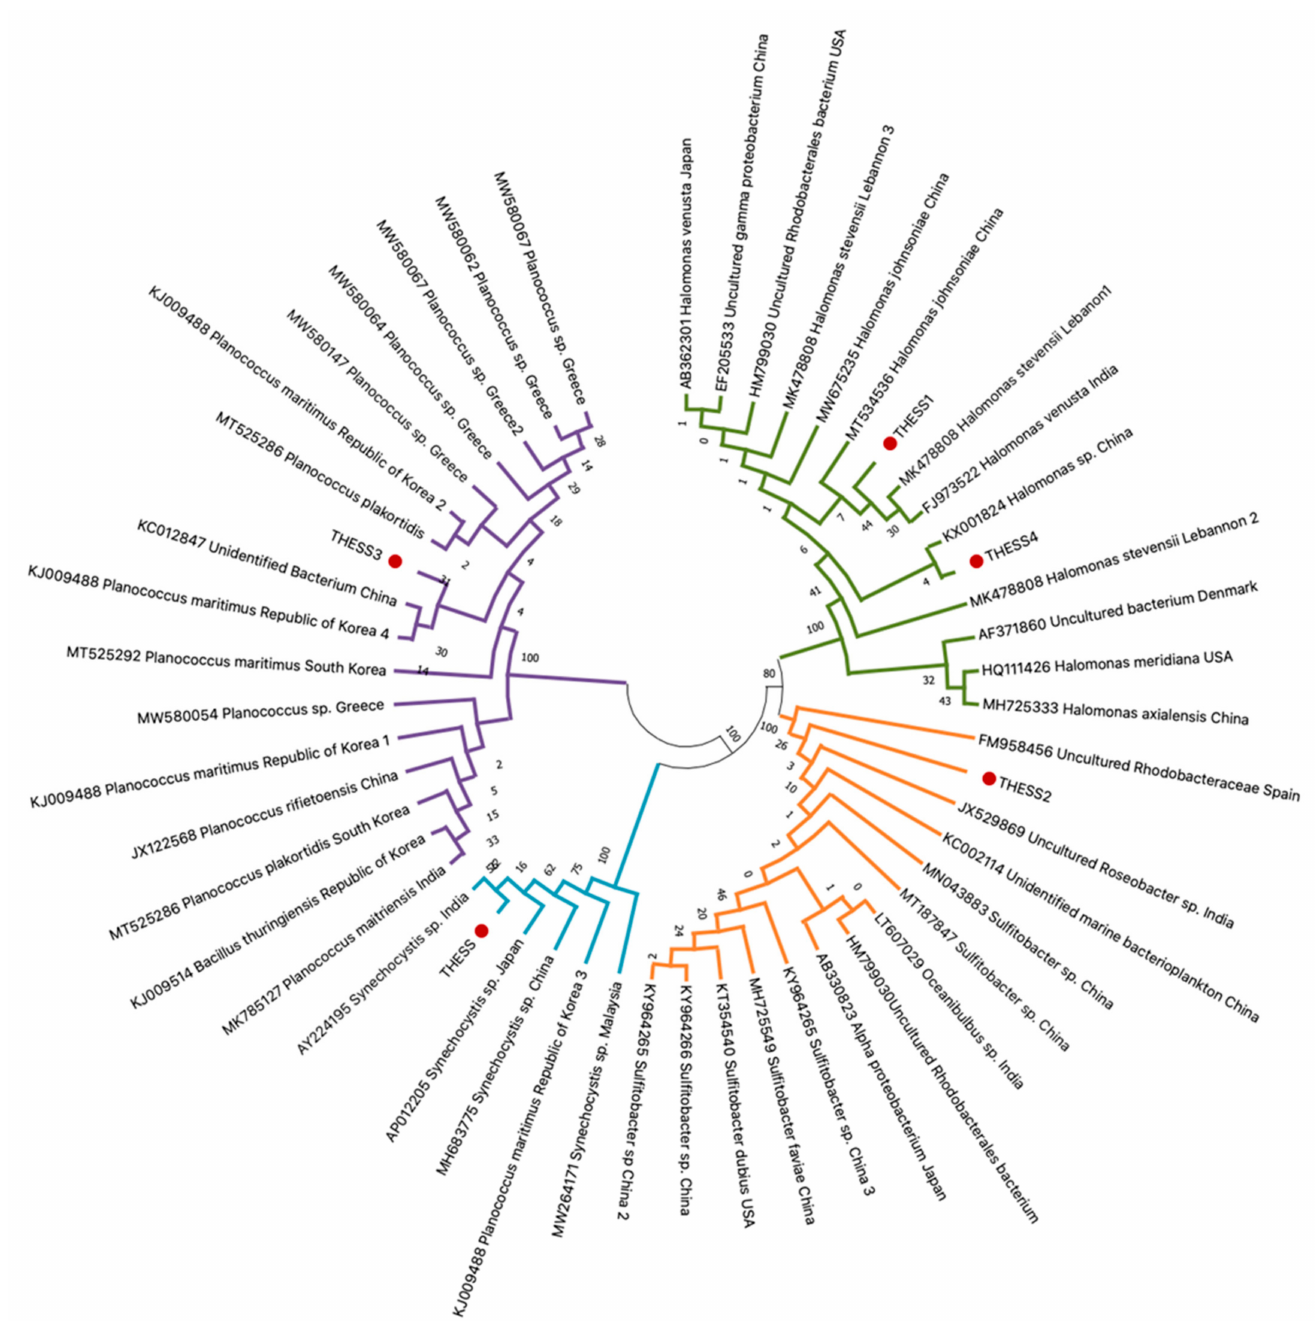
Figure 2. Neighbor-joining (NJ) dendrogram depicting the phylogenetic relationships of the 16S rRNA haplotypes originating from seawater samples from mussel aquaculture in the Thermaikos gulf, with the most closely related congeneric haplotypes available in the GenBank database. Accession number, taxonomic classification, and geographic origin for each haplotype obtained from GenBank are indicated on each branch. Novel sequences derived in the present study are indicated with red dots. Confidence intervals based on 1000 iterations are demonstrated on each